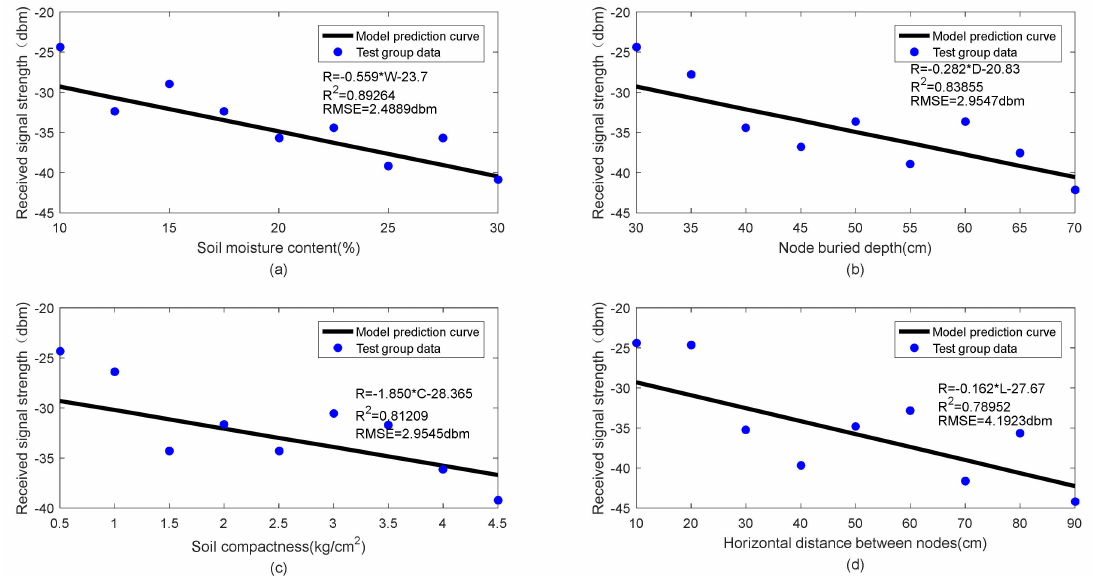
Figure 8. ( a – d ) Comparison between prediction results of single-factor attenuation model and experimental data.